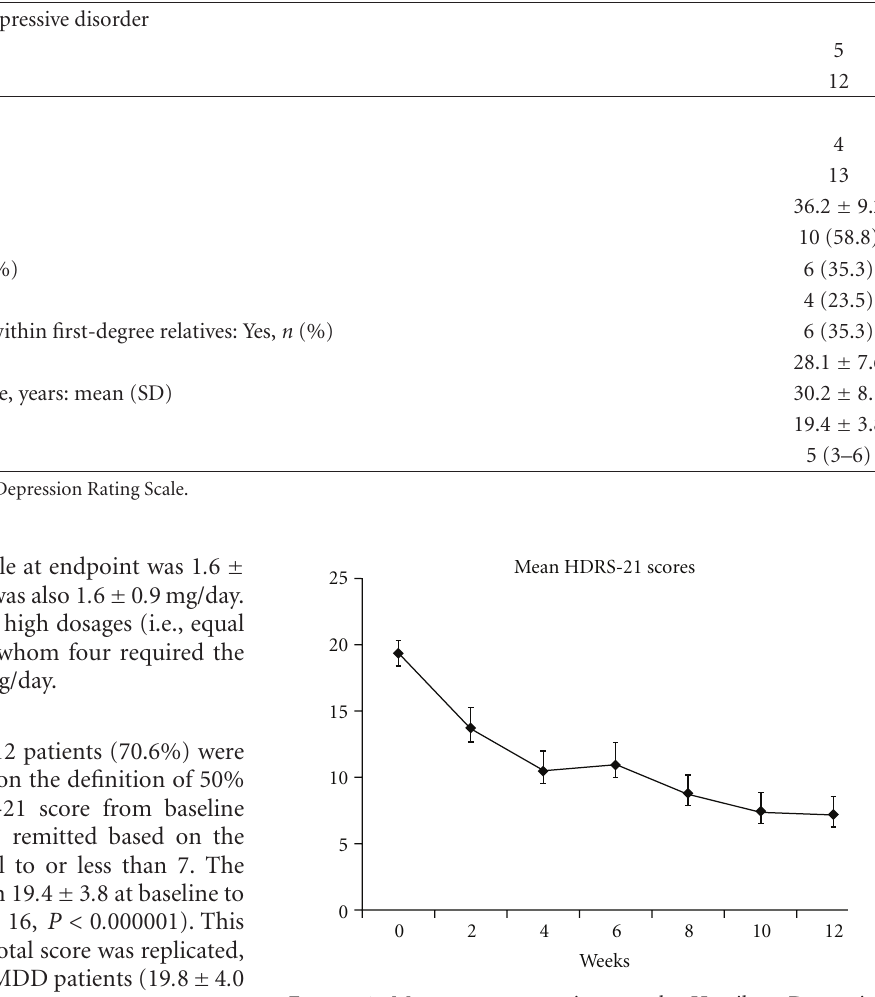
Figure 1: Mean scores over time on the Hamilton Depression Rating Scale (HDRS) 21-item version of the sample ( n = 17), based on the intent-to-treat analysis. Error bars represent standard errors of the